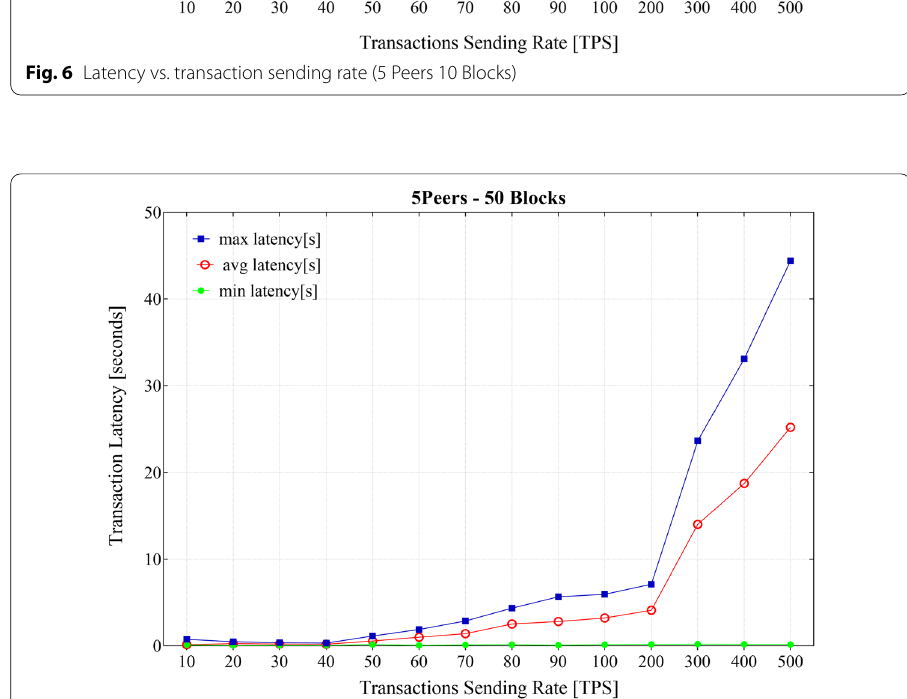
Fig. 7 Latency vs. transaction sending rate (5 Peers 50